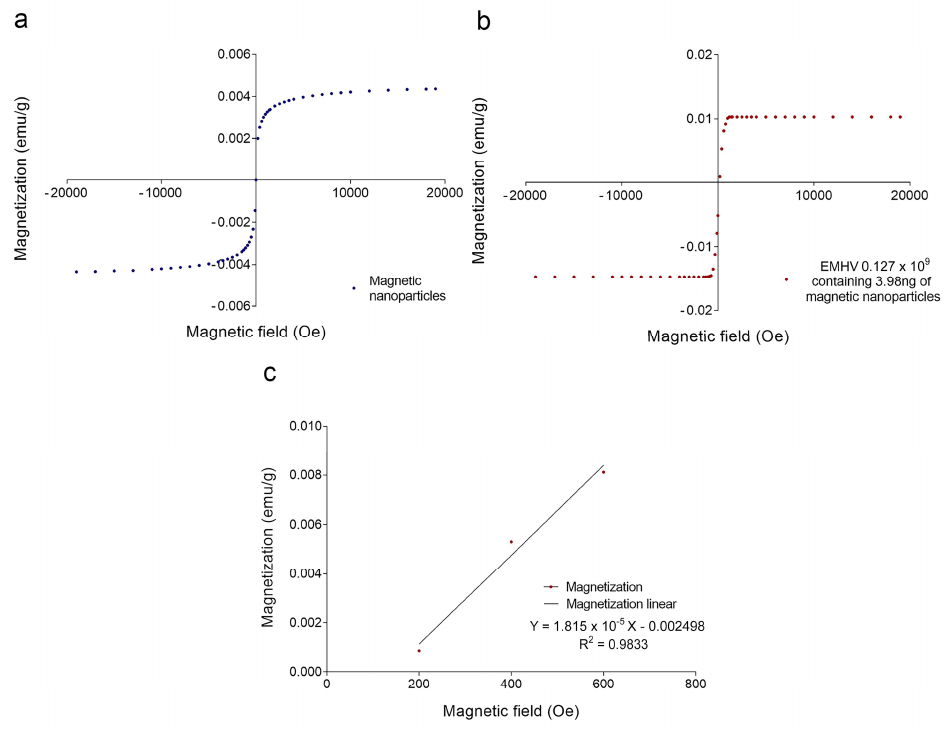
Figure 2. ( a ) Magnetization curve (emu g − 1 ) of a dried sample of superparamagnetic nanoparticles in response to a magnetic field (Oe); ( b ) Average magnetization (emu g − 1 ) of 0.127 × 10 9 EMHV dried samples in response to magnetic field (Oe); ( c ) Average magnetization (emu g − 1 ) in response to the magnetic field (Oe) in the region of magnetic field between 200 and 600 Oe. The slope of the line that best approximates this data series represents the mass magnetic susceptibility ( χ m,CGS ) of the EMHVs.